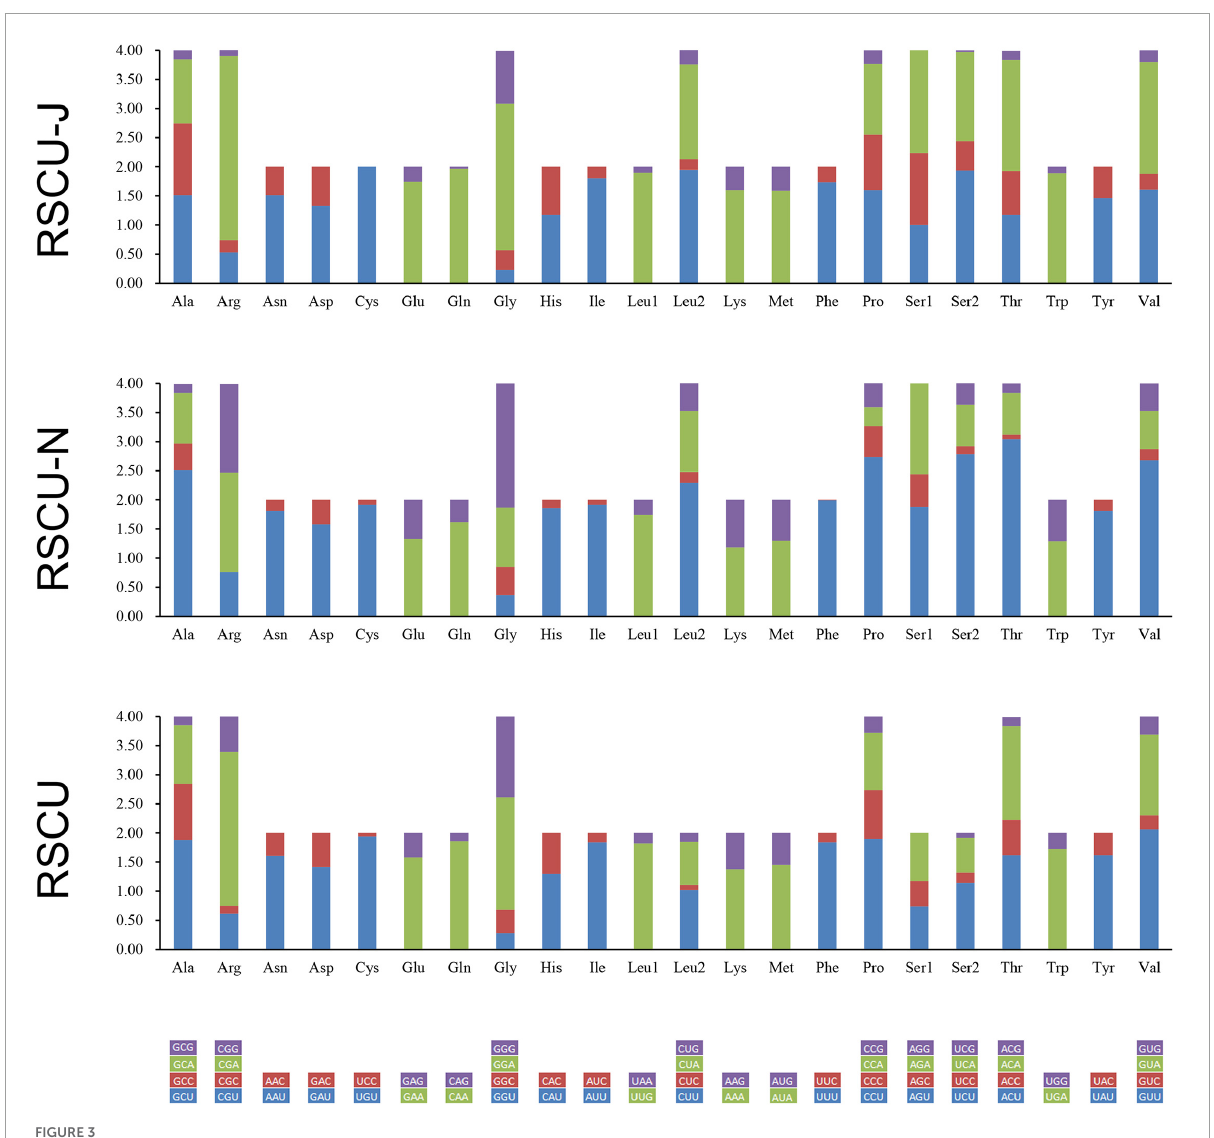
FIGURE3 Relative synonymous codon usage (RSCU) of S. jisigouense